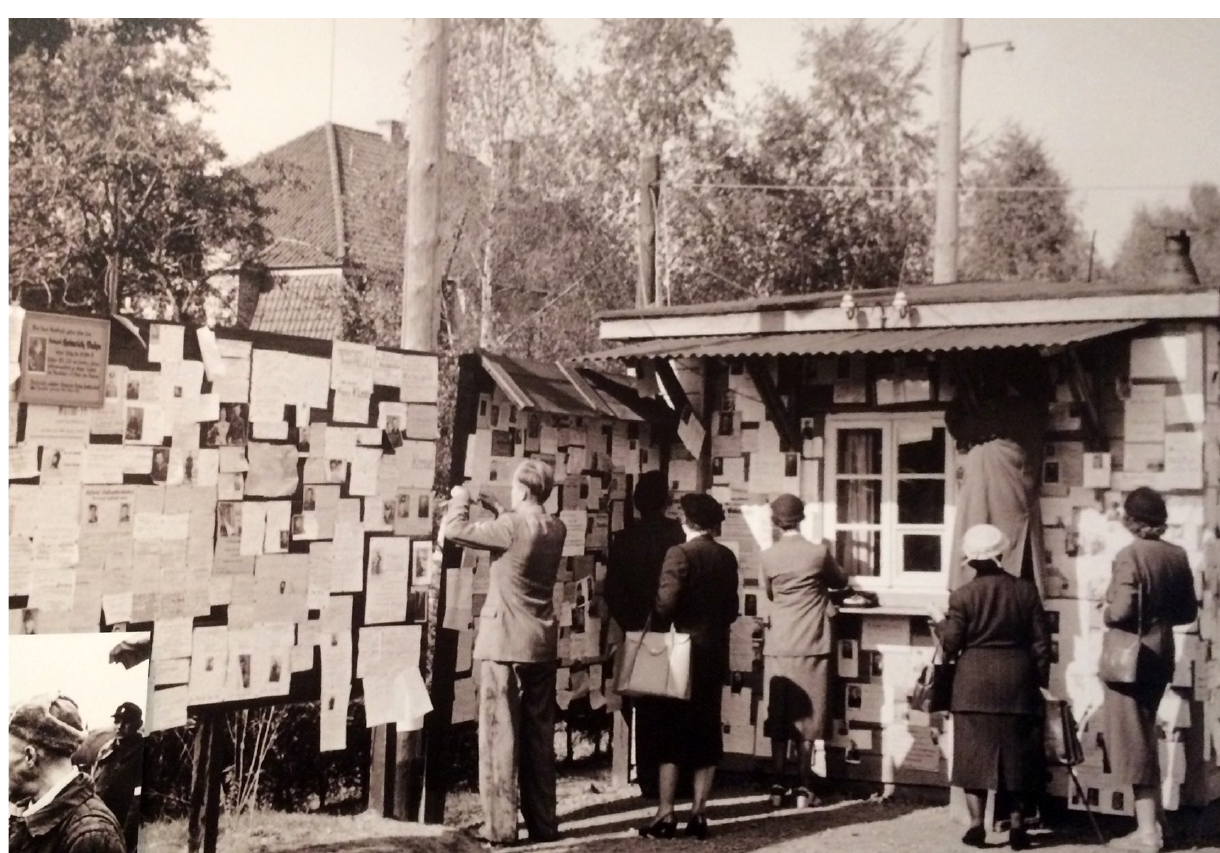
Figure 1. Camp residents in Friedland communicating via blackboards and walls of the camp buildings (© Museum